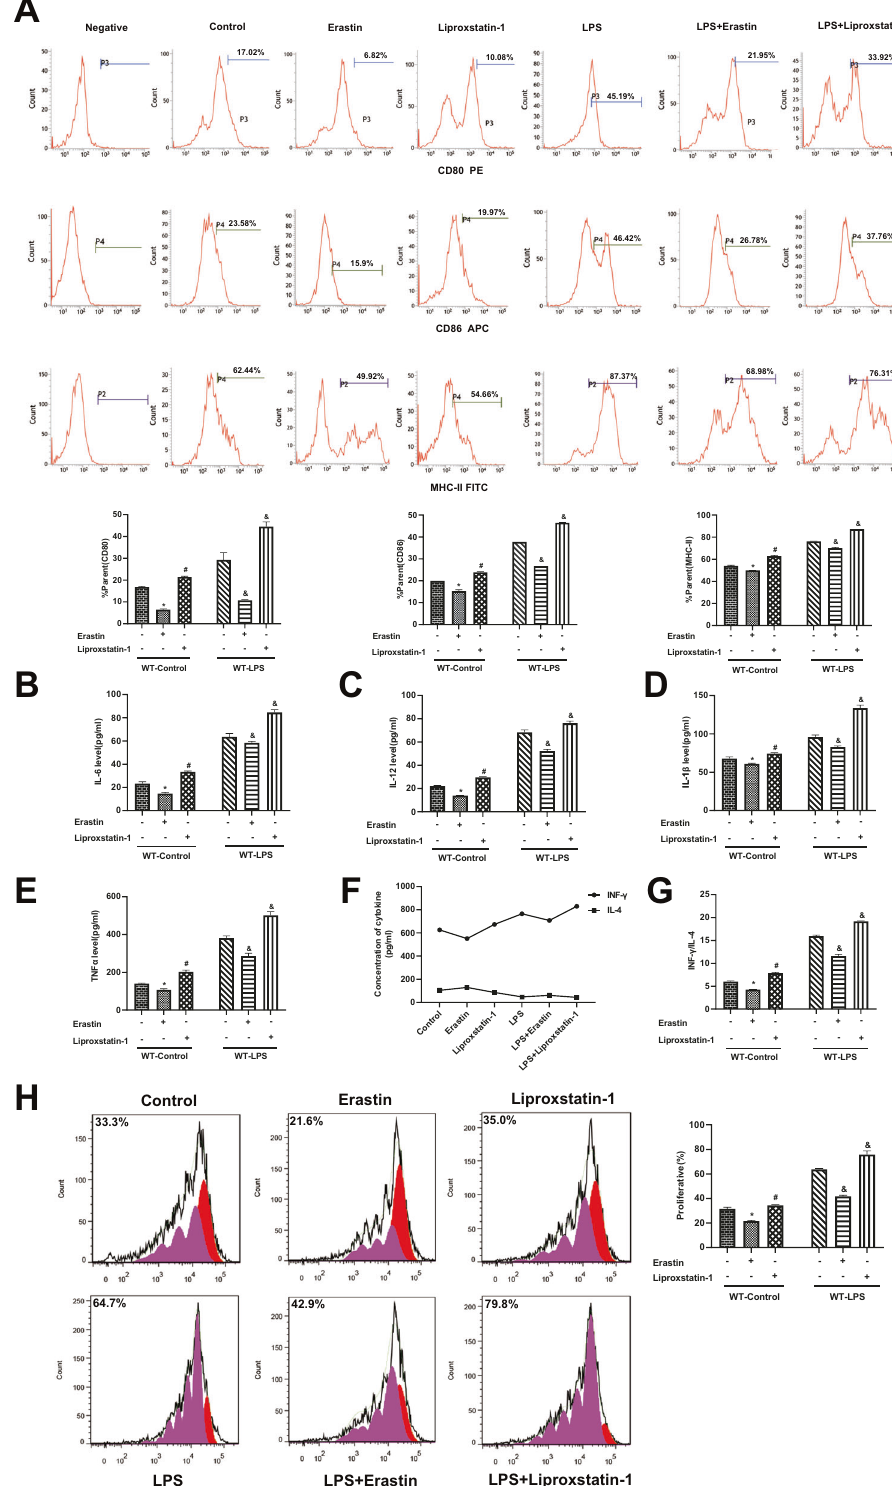
Fig. 2 LPS-induced ferroptosis results in a negative effect on the immune function of DCs. DCs were respectively pretreated with Era (20 μ M) and Lip-1 (1 μ M) 1 h prior to LPS stimulation. A Percentages of co-stimulatory phenotypes expressed on DCs. B – E Supernatant levels of IL-12, IL-6, IL-1 β , and TNF- α in cultured DCs were detected by ELISA. F – G CD4 + T cells stained with Con A were incubated with DCs at a ratio of 1:200. Levels of IFN- γ and the IFN- γ /IL-4 ratio were examined by ELISA to evaluate Th1/Th2 polarization. H Stimulated DCs were cocultured with CD4 + T cells incubated with Con A, and then T-cell proliferation induced by DCs was evaluated by fl ow cytometry. The results were shown as the as mean ± SD ( n = 3 in each group). Statistical signi fi cance: * P < 0.05 for the WT-Era group vs. the WT-control group; # P < 0.05 for the WT-Lip-1 group vs. the WT-Era group; & P < 0.05 vs. the WT-LPS